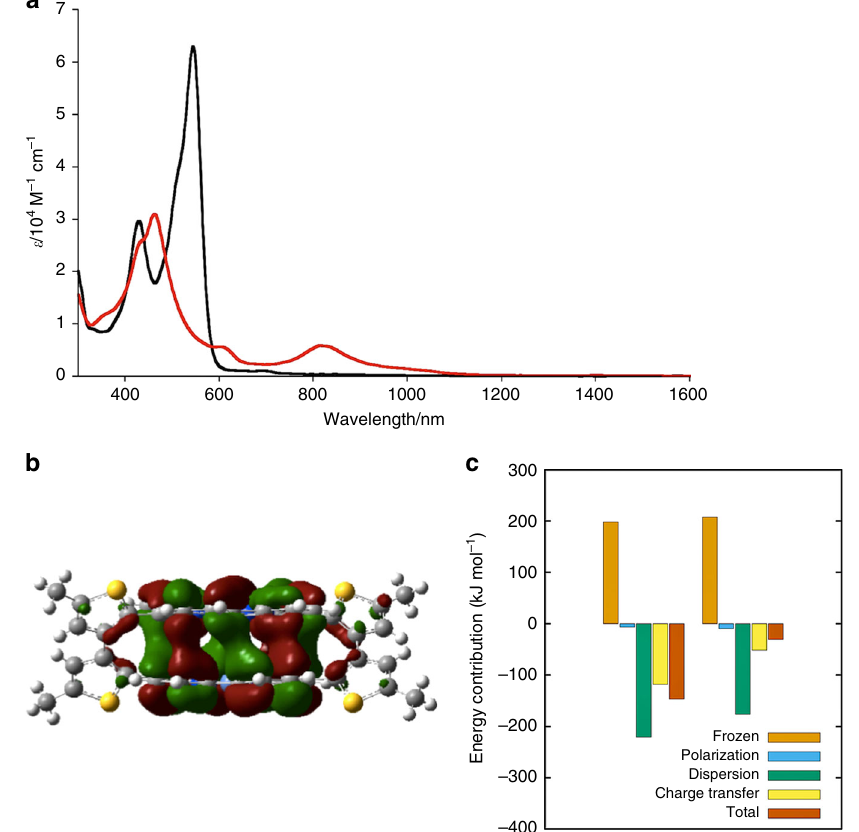
Fig. 5 Interactions between the two antiaromatic norcorrole subunits. a UV/Vis/NIR absorption spectra of 6 (black) and 5 (red) in dichloromethane. b The HOMO – 1 of 5 calculated at the CAM-B3LYP/6-31G(d) level of theory. c Decomposition of the total intermolecular interaction energy in kJ mol – 1 of 5 ′ for the crystal-structure geometry (left) and the crystal-structure geometry without the Ni atoms